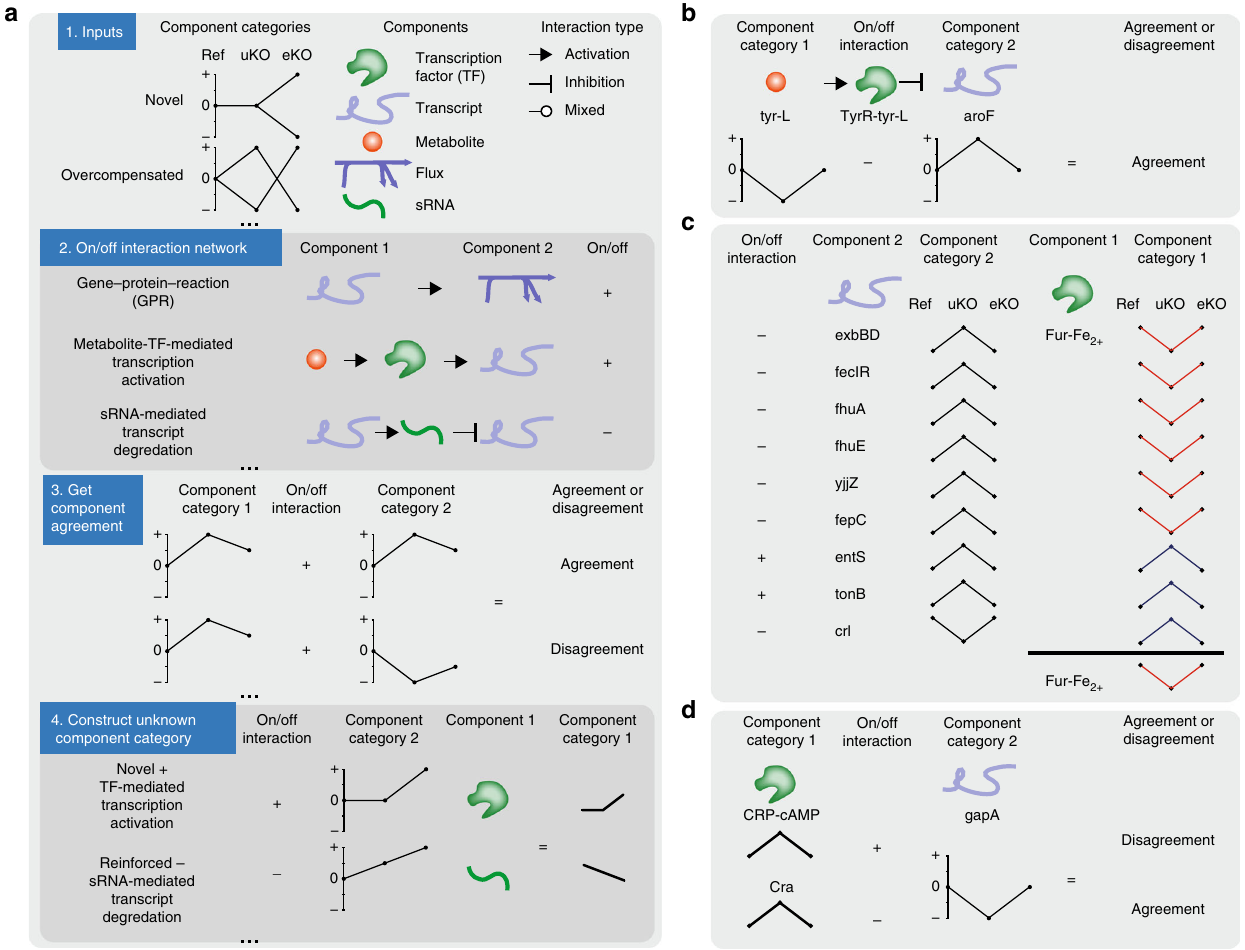
Fig. 5 Mapping between network components and annotated regulation. a An algorithm for determining agreement and disagreement between system components categories and annotated biochemical pathways and regulation. 1. The algorithm inputs include the component pro fi les, the network components, and the network interactions. 2. An on/off Boolean interaction network that describes the biochemical and/or regulatory relationship between two components is constructed. 3. The component categories and on/off interaction between each component can then be determined. 4. For components that were not directly measured, a consensus category and con fi dence score can be determined. b Example of metabolite-mediated transcription factor activation between tyr-L, TyrR, and aroF 53 . c Example of an unresolved discrepancy involving Fur regulation. d Example of